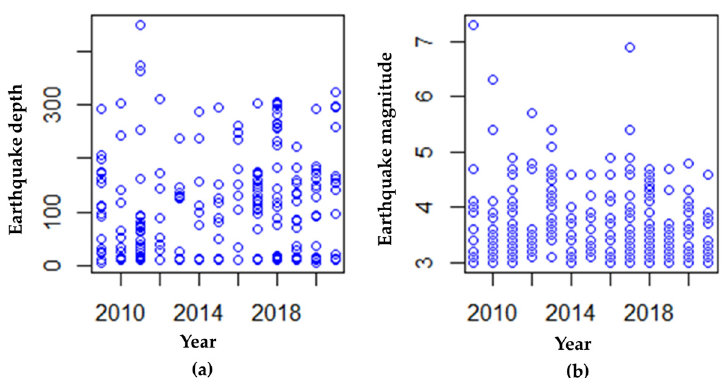
Figure 4. ( a ) earthquake depth ( b ) earthquake magnitude in West Java Province from 2009 to 2021, the depth and magnitude of earthquakes are shown on blue circles each year